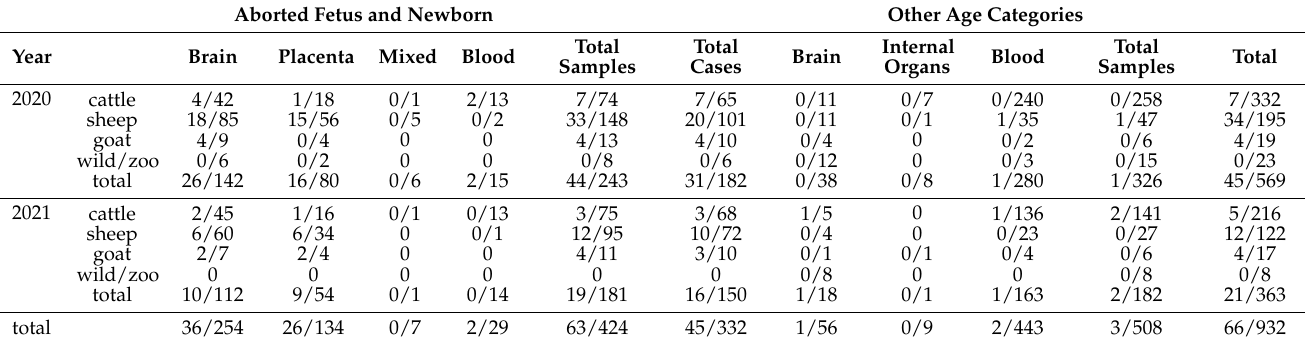
Table 1. Field samples tested by panSimbu RT-qPCR during